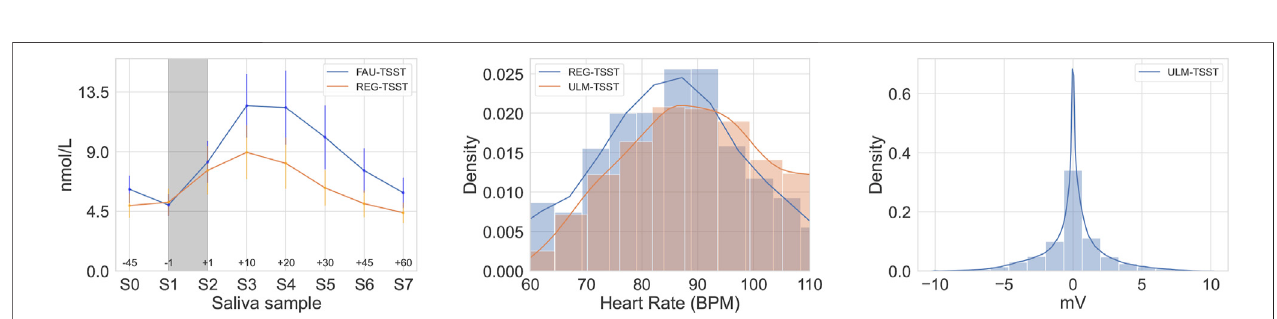
FIGURE 2 | Mean of raw cortisol as (nmol/L) for both FAU-TSST and REG-TSST , highlighting the stress period in grey, with annotations of sequential saliva (S), and sample time in minutes (left) . Distribution of continuous heart rate as BPM for the REG-TSST and ULM-TSST corpora (middle) . Distribution of the respiration-based signal as millivolts (mV) based on chest displacement (right)